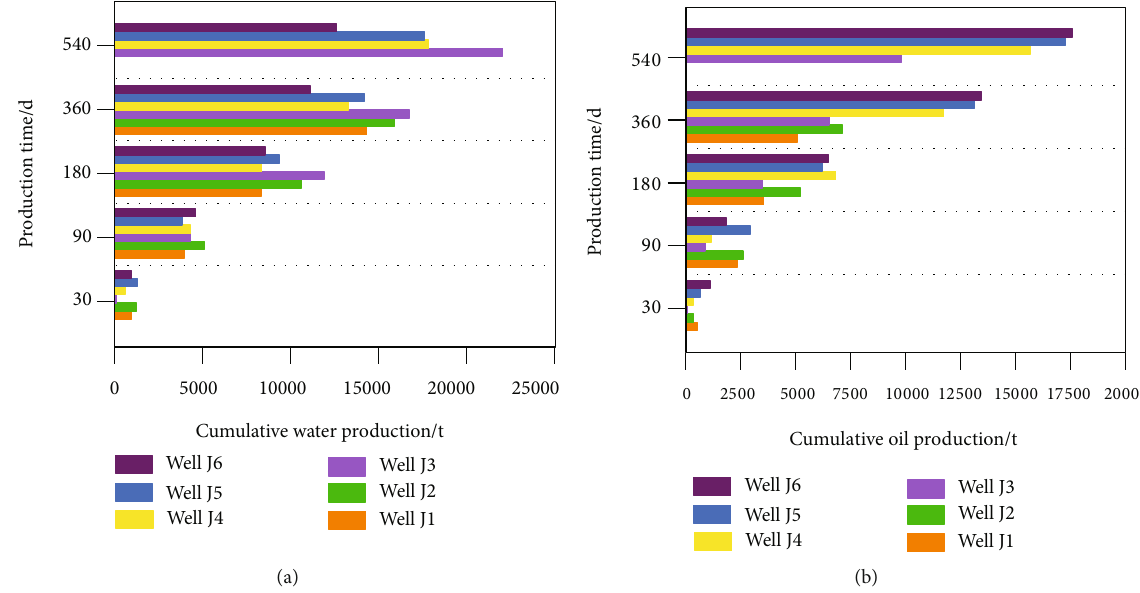
Figure 15: Di ff erent well closures and developments of well J1 – J6: (a) cumulative water production and (b) cumulative oil